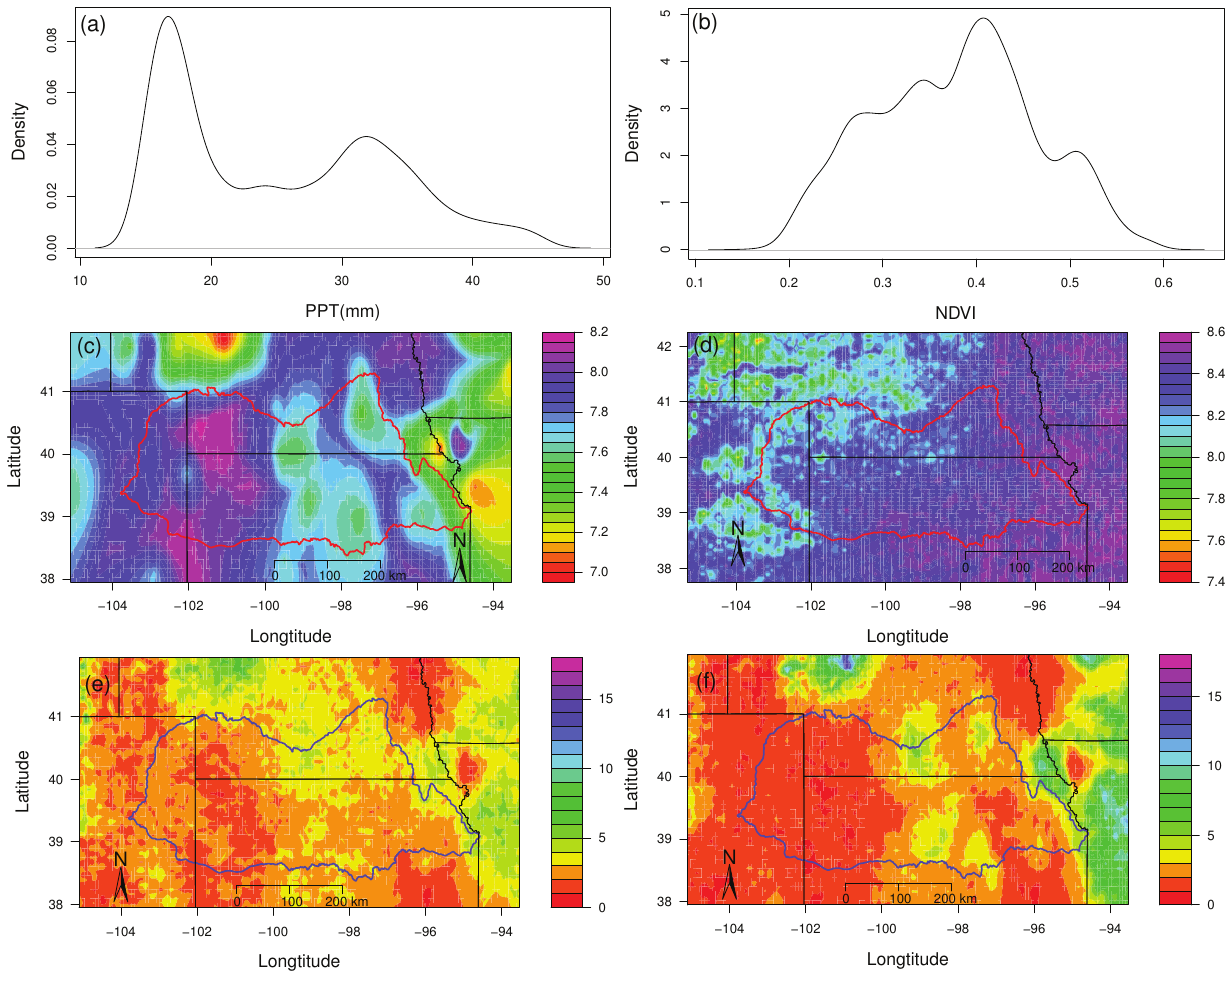
Figure 3. The probability density functions of ( a ) 15-day totals PPT and ( b ) NDVI using the entire record for the calculation of entropy of PPT and NDVI. Maps of per-pixel entropy of ( c ) PPT and ( d ) NDVI; and per-pixel relative entropy between ( e ) PPT and NDVI and ( f ) NDVI and PPT. The values of entropy and relative entropy are calculated by using the non-transformed version of PPT and